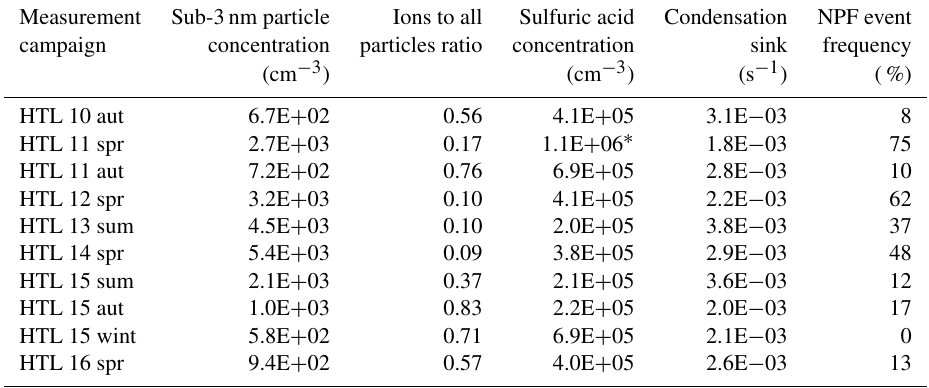
Table 3. Medians of sub-3nm particle concentration, the ratio of ion concentration to the total sub-3nm particle concentration, sulfuric acid concentration, condensation sink, and the frequency of new particle formation (NPF) events in Hyytiälä during different measurement campaigns. Sulfuric acid concentration is estimated from a proxy for all other campaigns except in spring 2011.